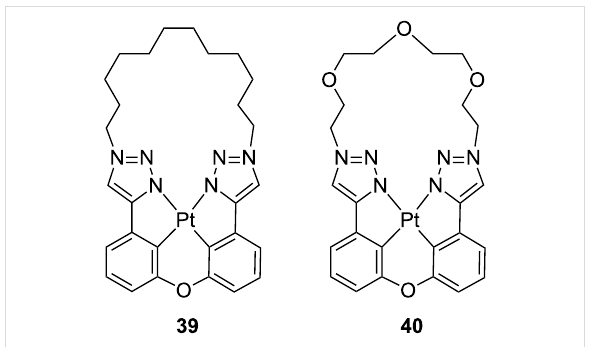
Figure 18: Chemical structure of the macrocyclic tetradentate plati- num complexes reported by Wang and co-workers